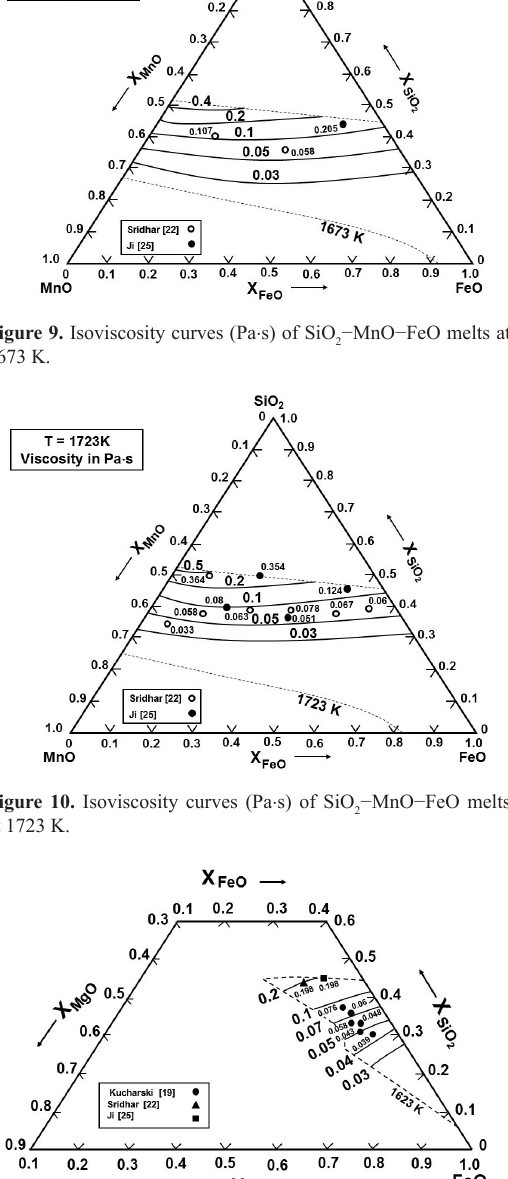
−MgO−FeO melts 2